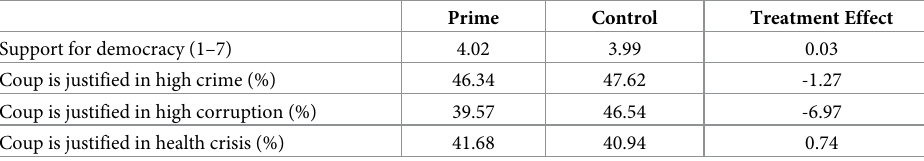
Table 2. Prime experiment results: Attitudes toward democracy and